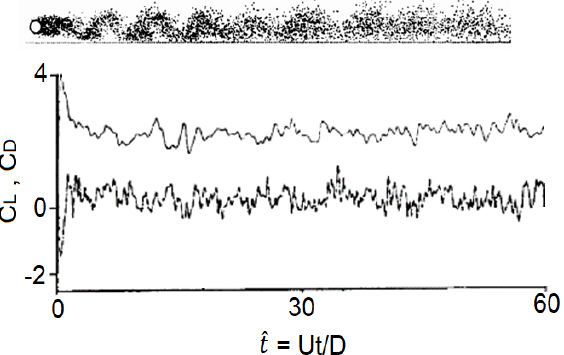
Figure 12. The flow pattern and force coefficients for G/D = 1 and Re = 100.